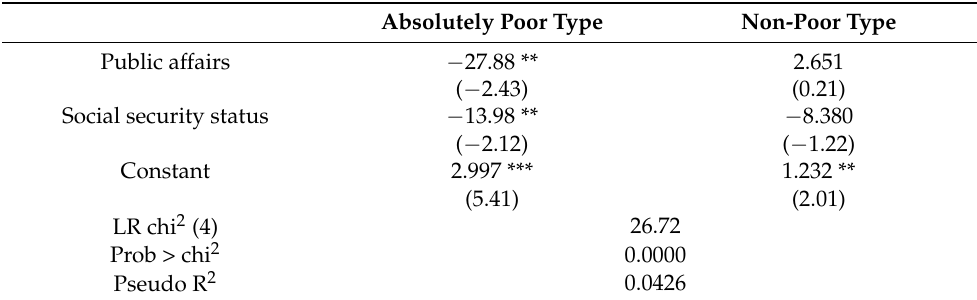
Table 6. Multinomial logistic regression results of the impact of public affairs and social security status on different types of